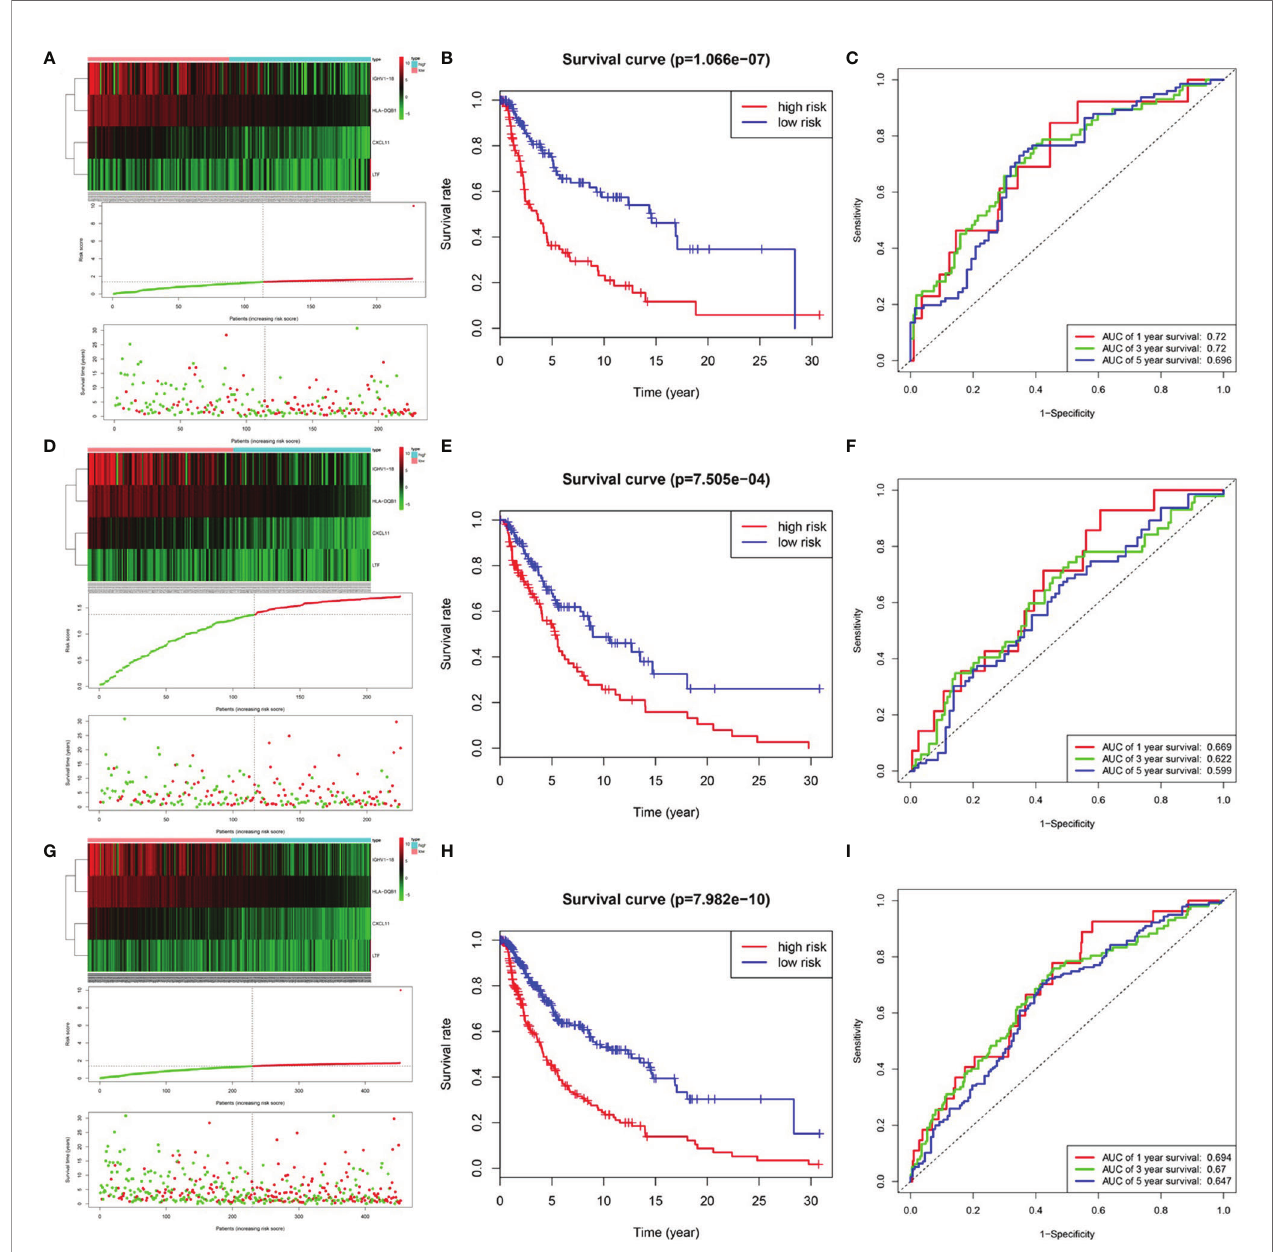
FIGURE 4 | Prognosis model of training, testing and entire cohort. (A) The risk score and survival status of training cohort. (B) Survival analysis between low-risk patients and high-risk patients of training cohort. (C) ROC curve analysis of training cohort. (D) The risk score and survival status of testing cohort. (E) Survival analysis between low-risk patients and high-risk patients of testing cohort (F) ROC curve analysis of testing cohort. (G) The risk score and survival status of entire cohort. (B) Survival analysis between low-risk patients and high-risk patients of entire cohort (H) Survival analysis between low-risk patients and high-risk patients of training cohort (I) ROC curve analysis of entire